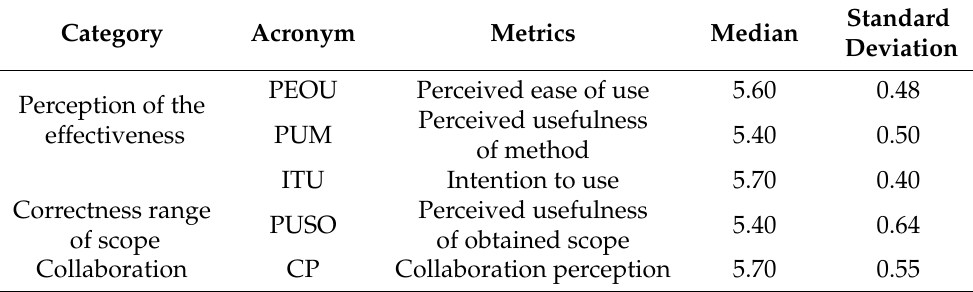
Table 7. Results of perception metrics.